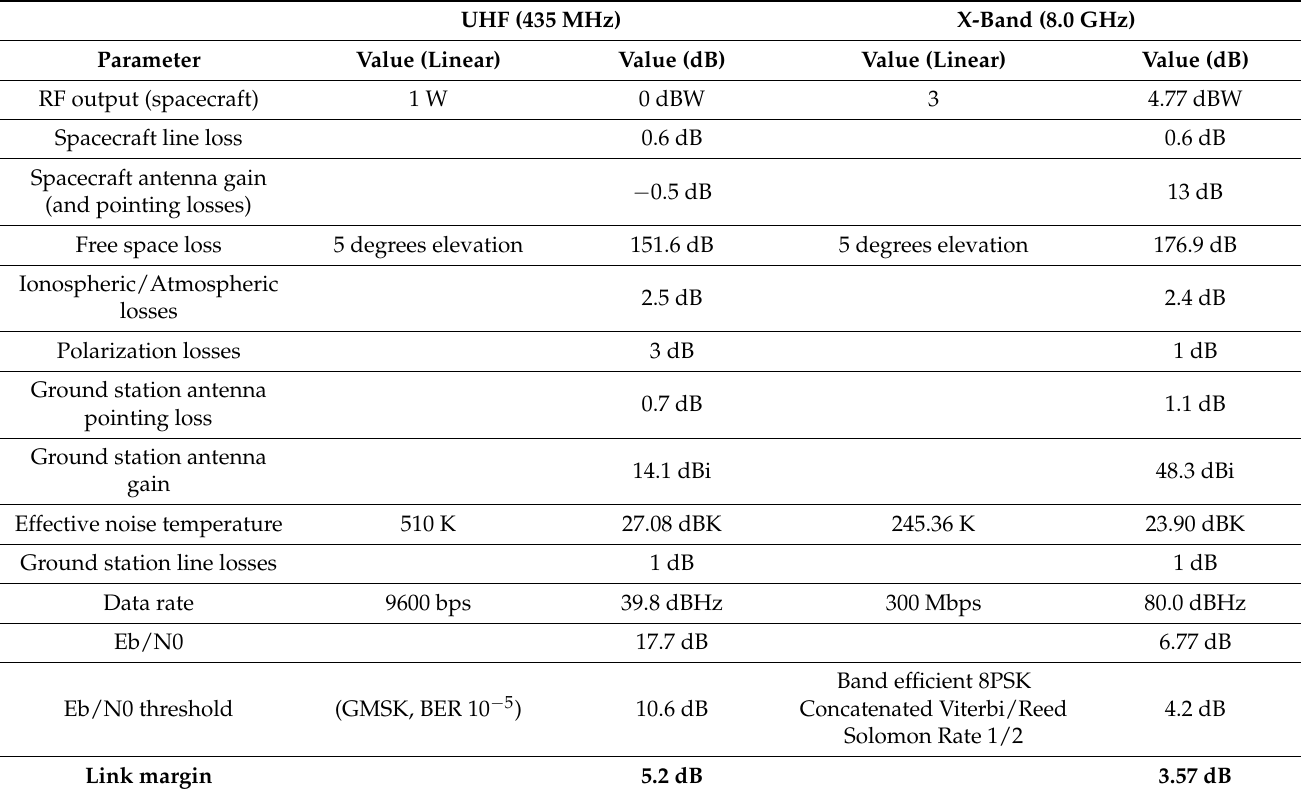
Table 12. Downlink link budgets (UHF and